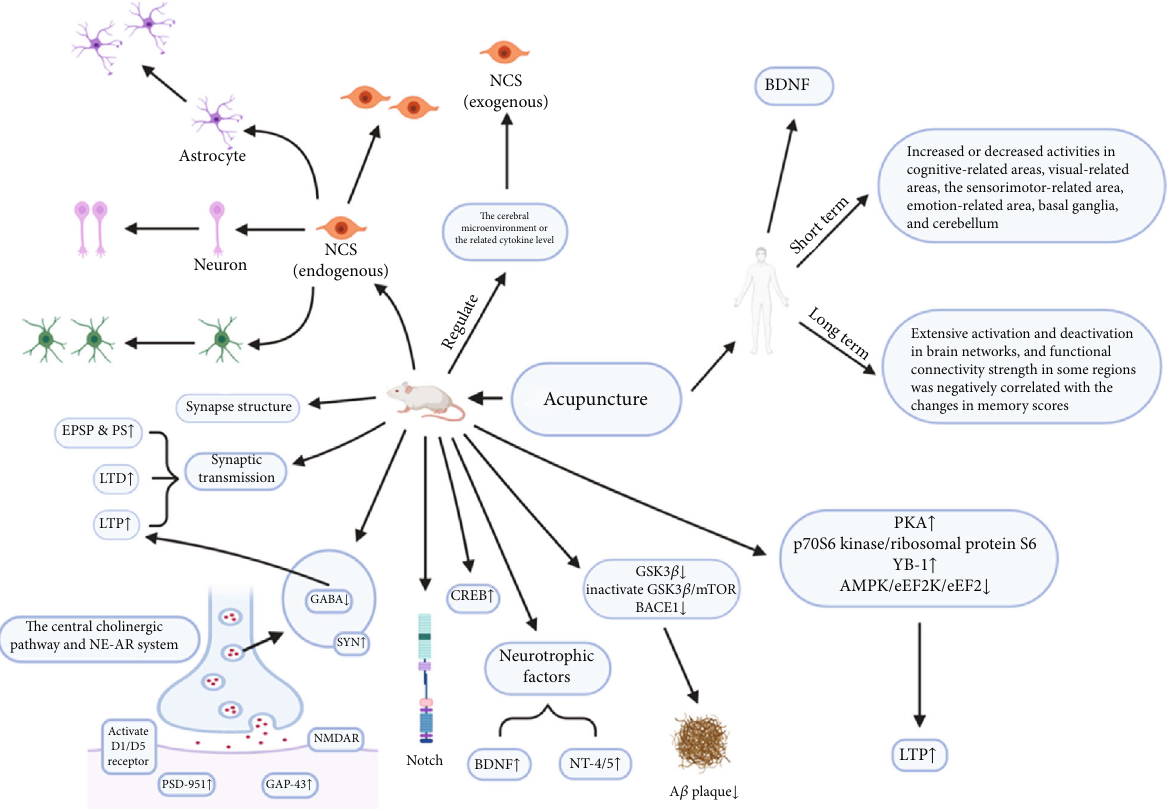
Figure 3: Mechanisms involved in acupuncture regulating neuroplasticity to improve cognitive